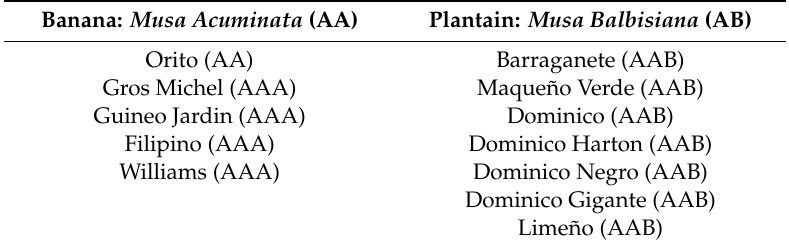
Table 2. Musa ecotypes used in the mixed-species plot according to their